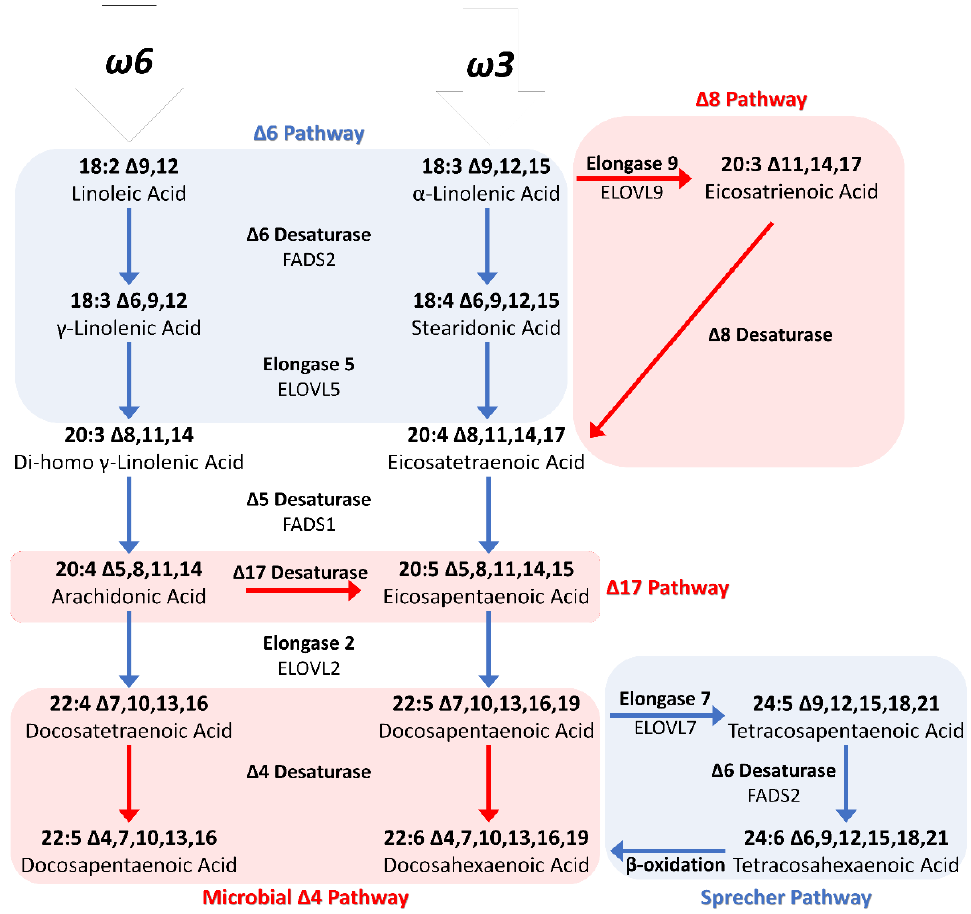
Figure 3. Biosynthesis of essential fatty acids. [79–81].